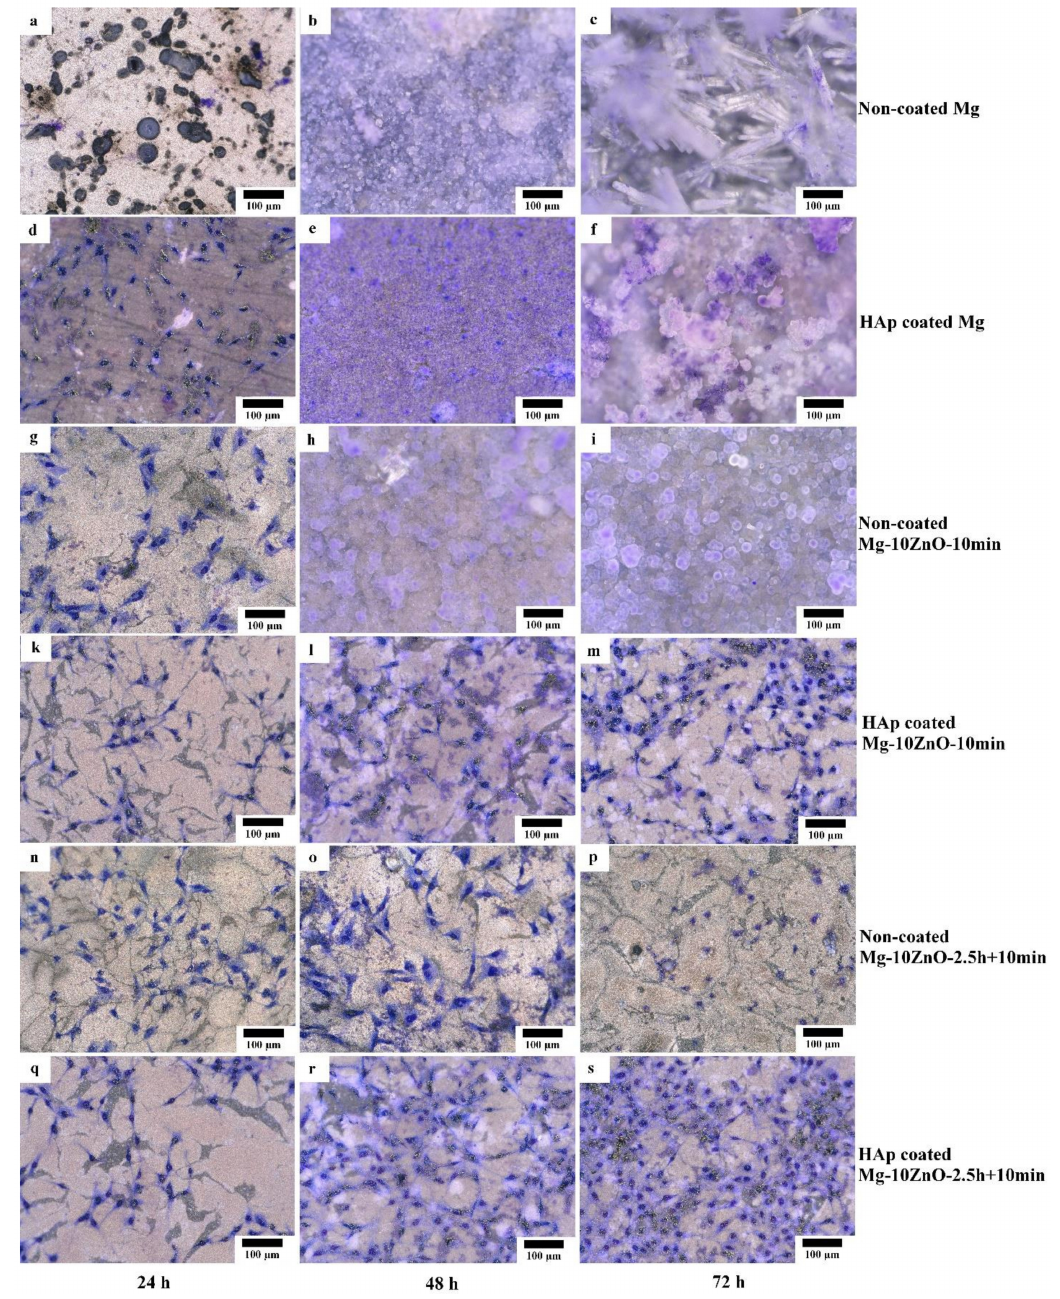
Figure 12. Morphology of the coated and uncoated samples after cell culture test for 24, 48, and 72 h, respectively. ( a,b,c ) uncoated Mg, ( d,e,f ) HAp coated Mg, ( g,h,i ) uncoated Mg-10ZnO-10min, ( k,l,m ) HAp coated Mg-10ZnO-10min, ( n,o,p ) uncoated Mg-10ZnO-2.5h + 10min, ( q,r,s ) HAp coated Mg-10ZnO-2.5h +